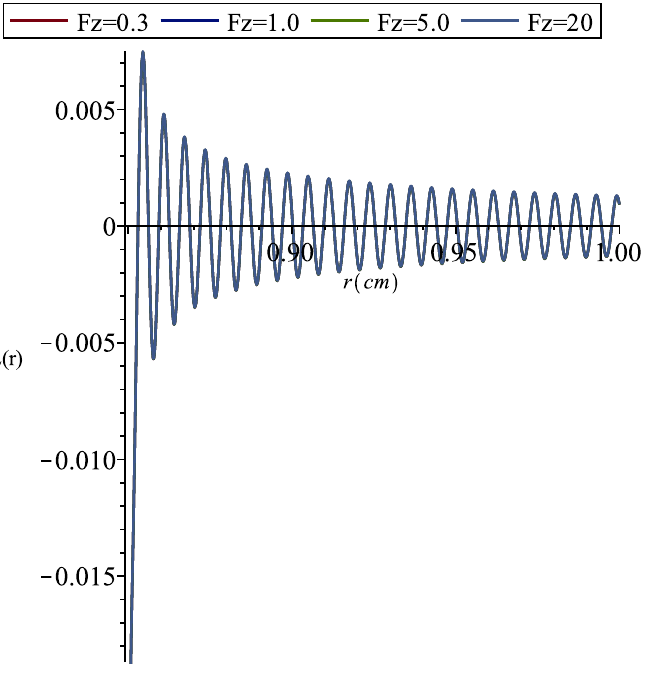
Figure 8. L ( r ) versus r , for α = − 1,000,000 corresponding to Figure 6 at different values of Fz